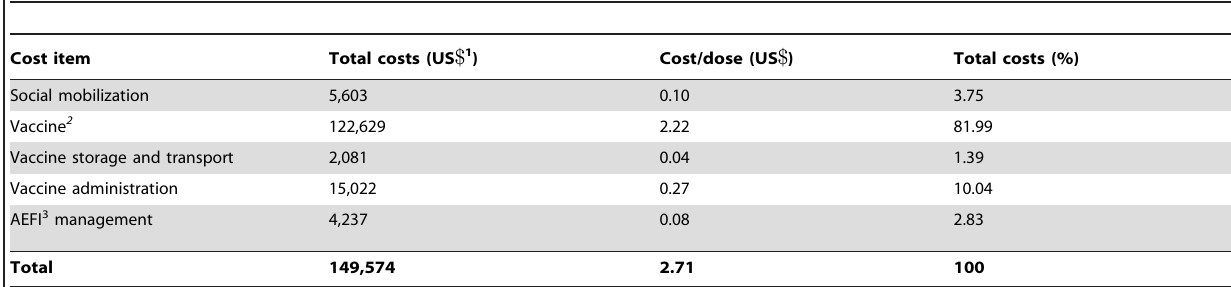
Table 4. Public sector costs (in 2011 prices) of cholera vaccination campaign in Satyabadi block in Odisha, India.